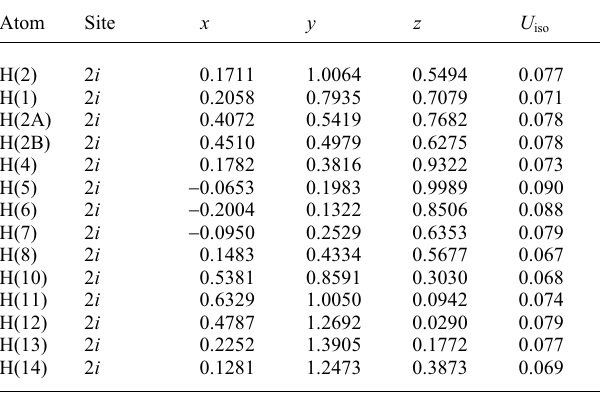
Table 2. Atomic coordinates and displacement parameters (in Å 2 ) .